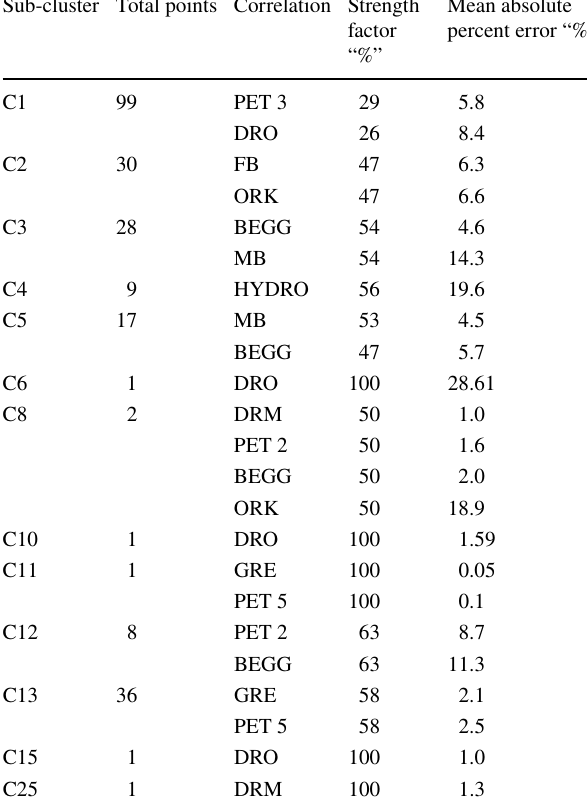
Table 12 Best correlations for cluster (D) Sub-cluster Total points Correlation Strength factor